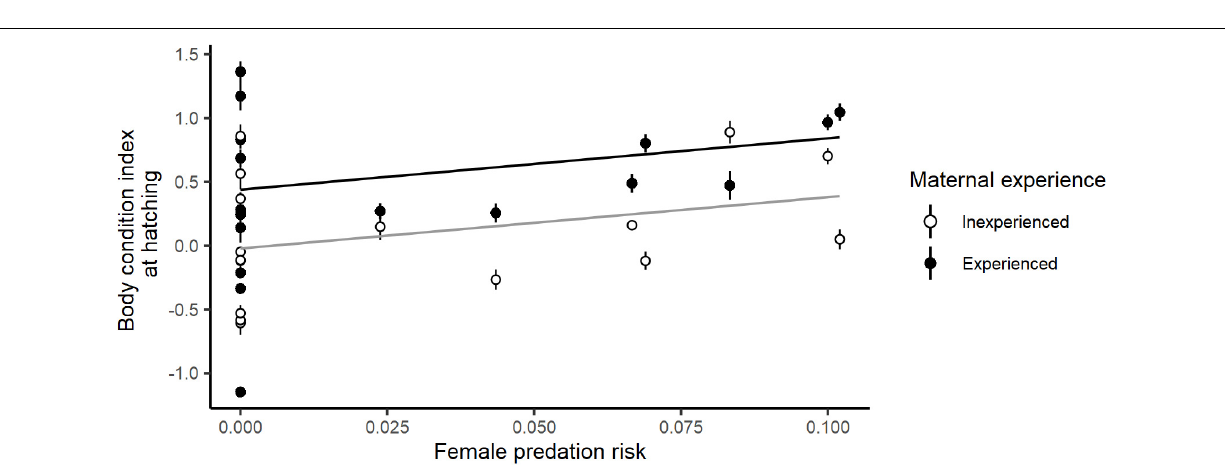
FIGURE 3 | Relationship between hatching success of female eiders and (A) baseline prolactin levels, (B) baseline log-transformed corticosterone levels, (C) island-specific nest predation risk, and (D) island-specific female predation risk.